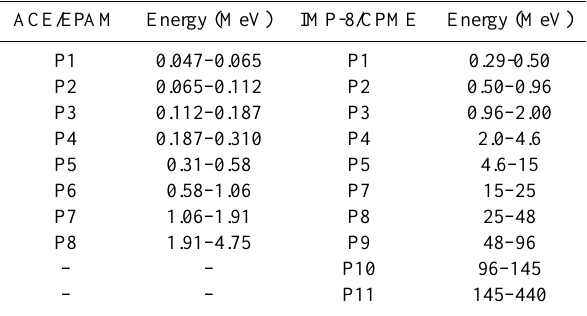
Table 1. Energy channels of the two selected space-borne energetic particle